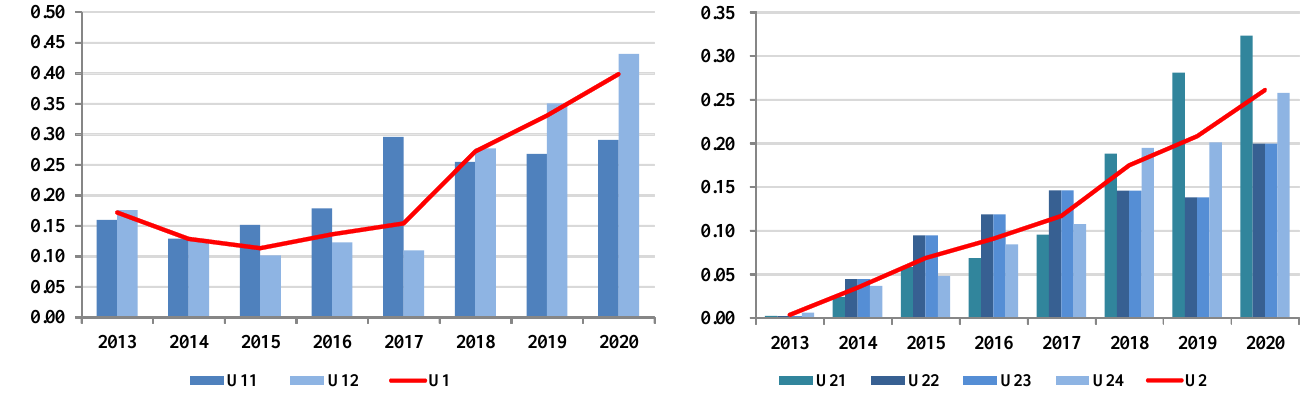
Figure 3. The comprehensive development level of Anhui Province’s LI and